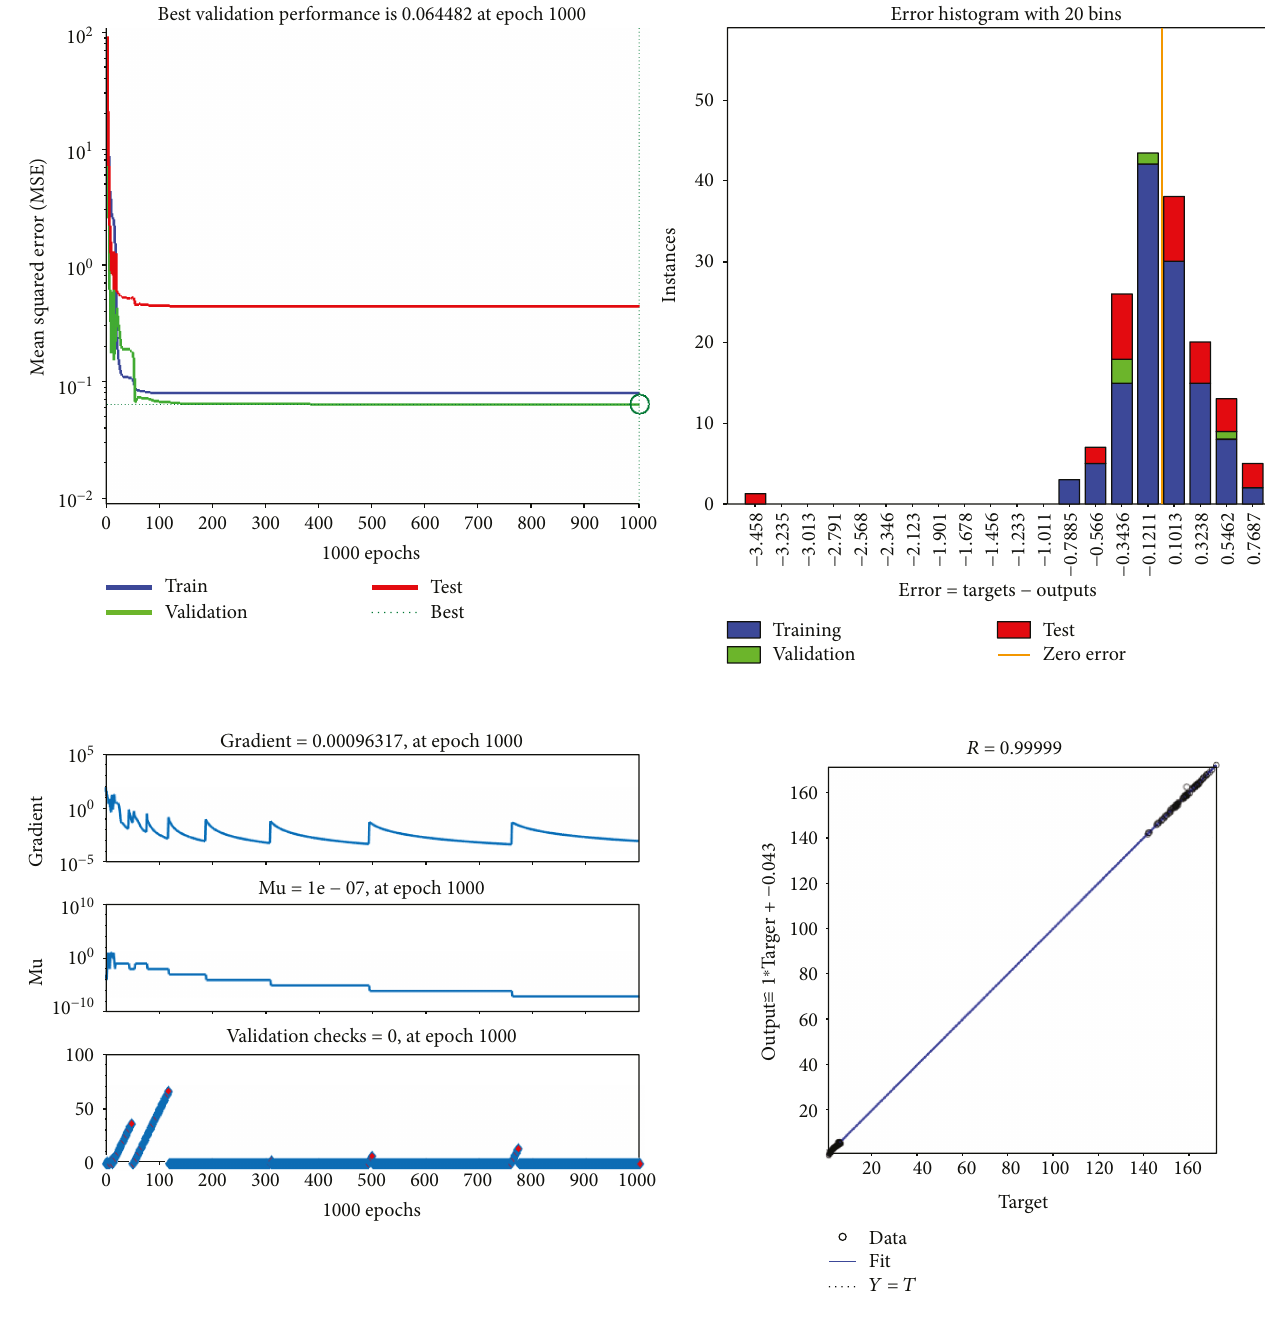
Figure 4: Neural network training state and error diagrams. Table 3: First layer weights and biases. Table 4: Second layer weights and